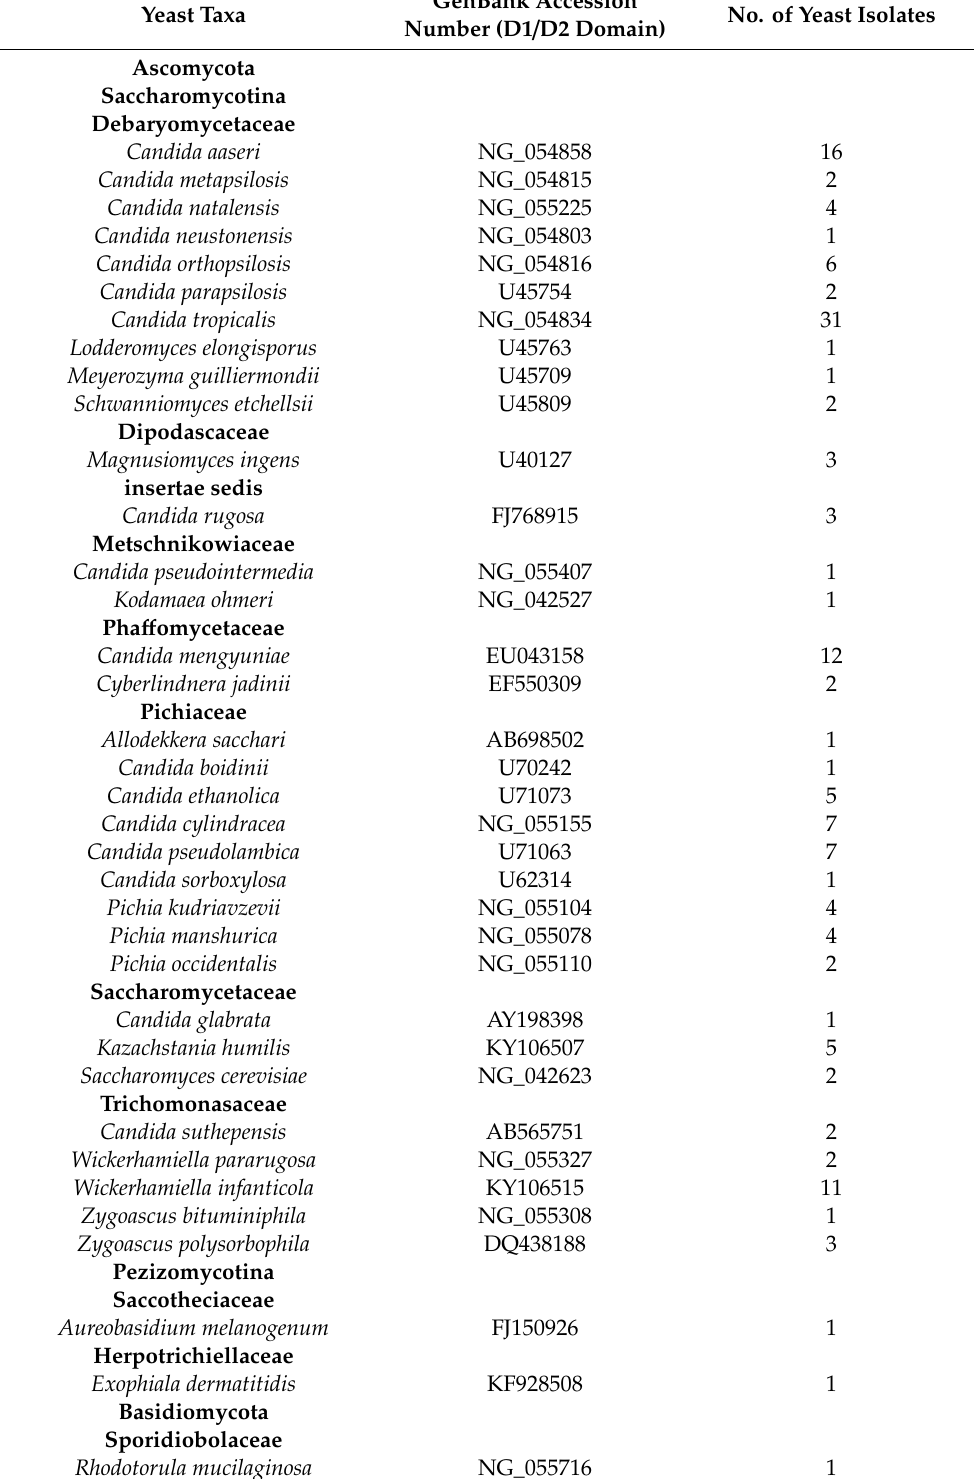
Table 1. Summary of described yeast discovered in grease